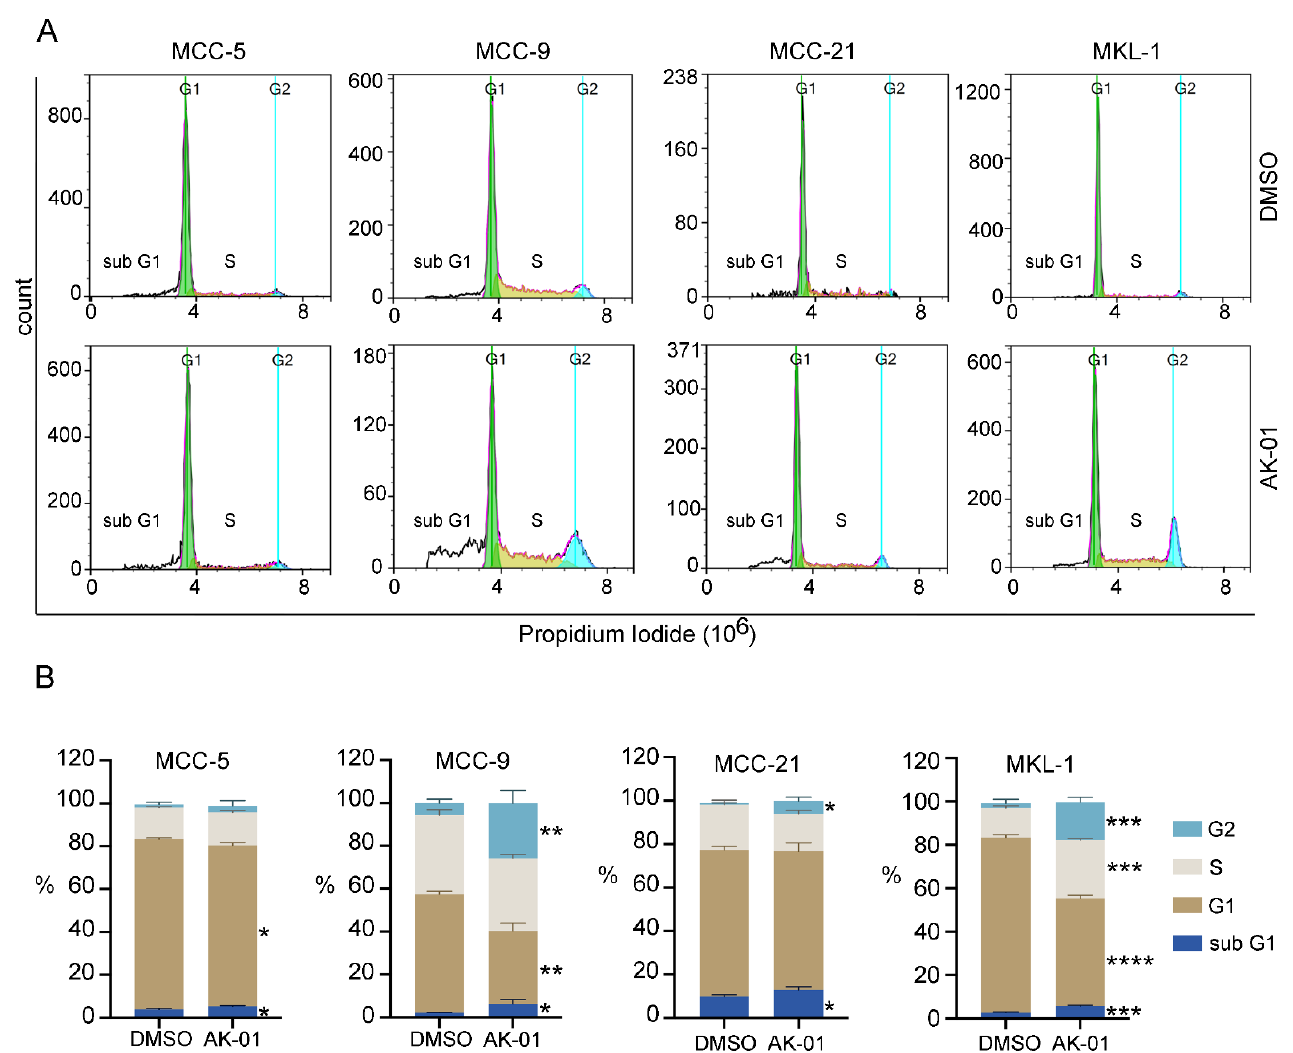
Figure 3. AK-01 induces G2-M cell cycle arrest and apoptosis in MCC cells. MCC cells were treated with vehicle (DMSO) or AK-01 300 nM for 48 h. Cells were then stained with PI (propidium iodide) and analyzed by flow cytometry. DMSO- treated cells served as controls. ( A ) DNA histograms of DMSO (upper panel) and AK-01 (lower panel) treated cells depict a significant increase in sub G1 (white), and G2 (cyan) populations of AK-01 treated MCC cells. ( B ) Percentage histograms depicting the distribution of MCC cell population in cell cycle phases: sub G1 (dark blue), G1 (light brown), S (light gray), and G2 (light blue). Data presented as mean ± SD ( n = 3). * refers to p < 0.05, ** refers to p < 0.005, *** refers to p < 0.0005, **** refers to p < 0.00005 vs. DMSO-treated cells by paired Student’s t -test. G1, growth 1 phase; G2, growth 2 phase; S phase, synthesis phase.